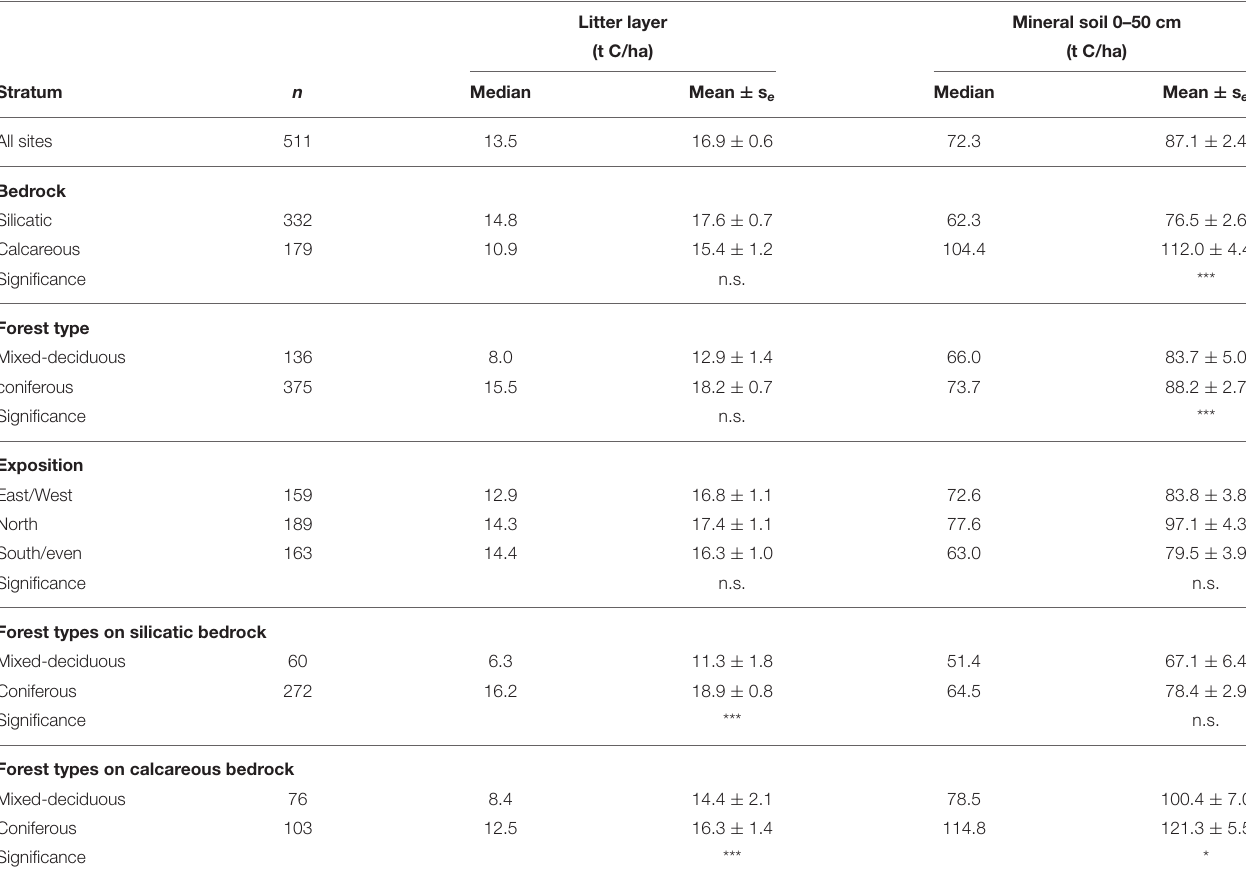
TABLE 2 | Soil organic carbon stocks (t C/ha) in Austrian forest soils stratified according to geological bedrock (silicatic vs. calcareous material), forest type (coniferous vs. mixed-deciduous), and slope exposition.